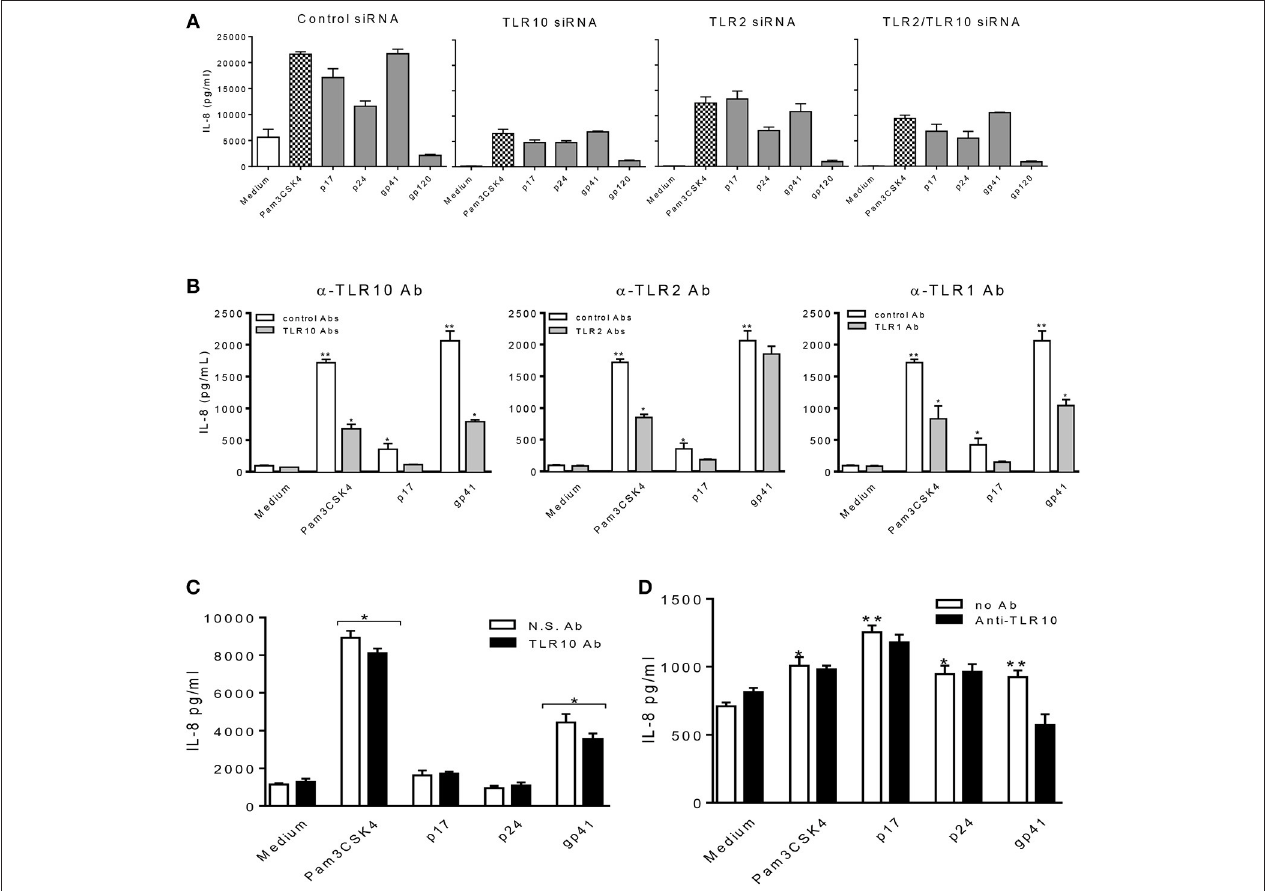
FIGURE 6 | HIV-1 proteins, p17 and gp41 elicit cellular responses through sensing TLR10, TLR2, and TLR1. IL-8 production stimulated by Pam3CSK4, p17, p24, and gp41 was greatly suppressed in THP-1 cells knocked-down of TLR10 with specific siRNA (A) and THP-1 cells neutralized with anti-TLR10 antibody (B) . (C) IL-8 stimulated by Pam3CSK4 and gp41 was reduced in MCF-10A cells neutralized with an anti-TLR10 antibody. (D) Primary BM cells displayed a significant decrease in IL-8 production induced by HIV-1 gp41 following neutralization with an anti-TLR10 antibody. Data set is representative of three different experiments completed in triplicate. Statistic marks: * p < 0.05 ; ** p < 0.01 for Mann Whitney t -tests, with each group compared to the medium treated group